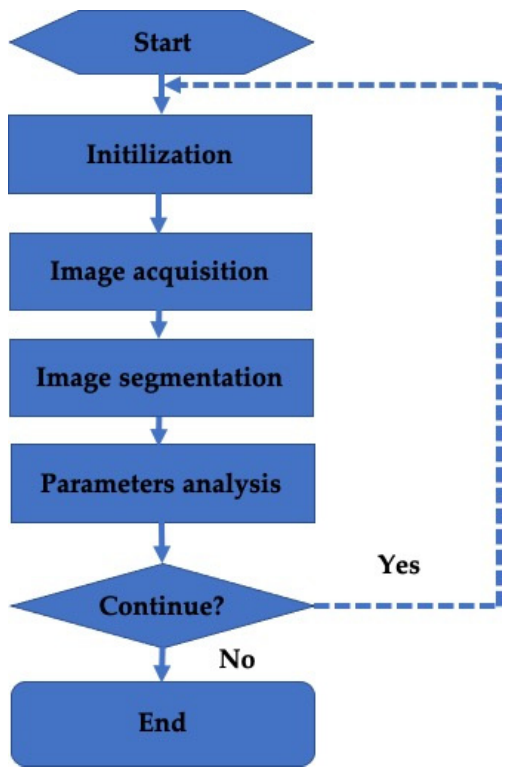
Figure 14. The typical algorithm used for image analysis (modified from [140]).